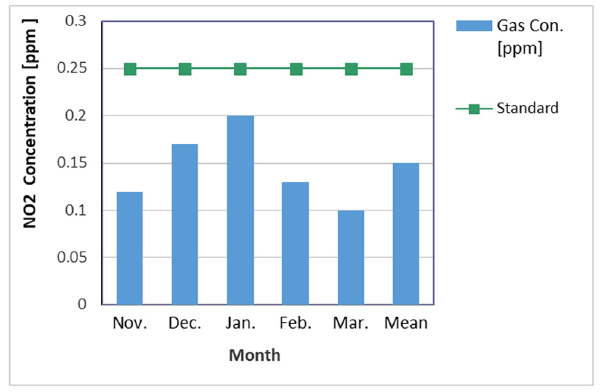
Figure 8: Monthly concentrations and overall mean of NO 2 gas during the study